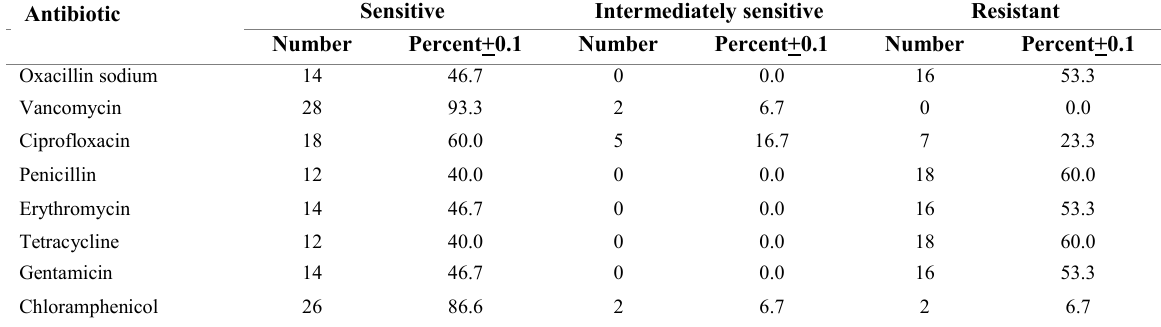
Table 2. The number of resistant and sensitive S. aureus strains to different antibiotics in disk diffusion test (Values expressed are averages of three